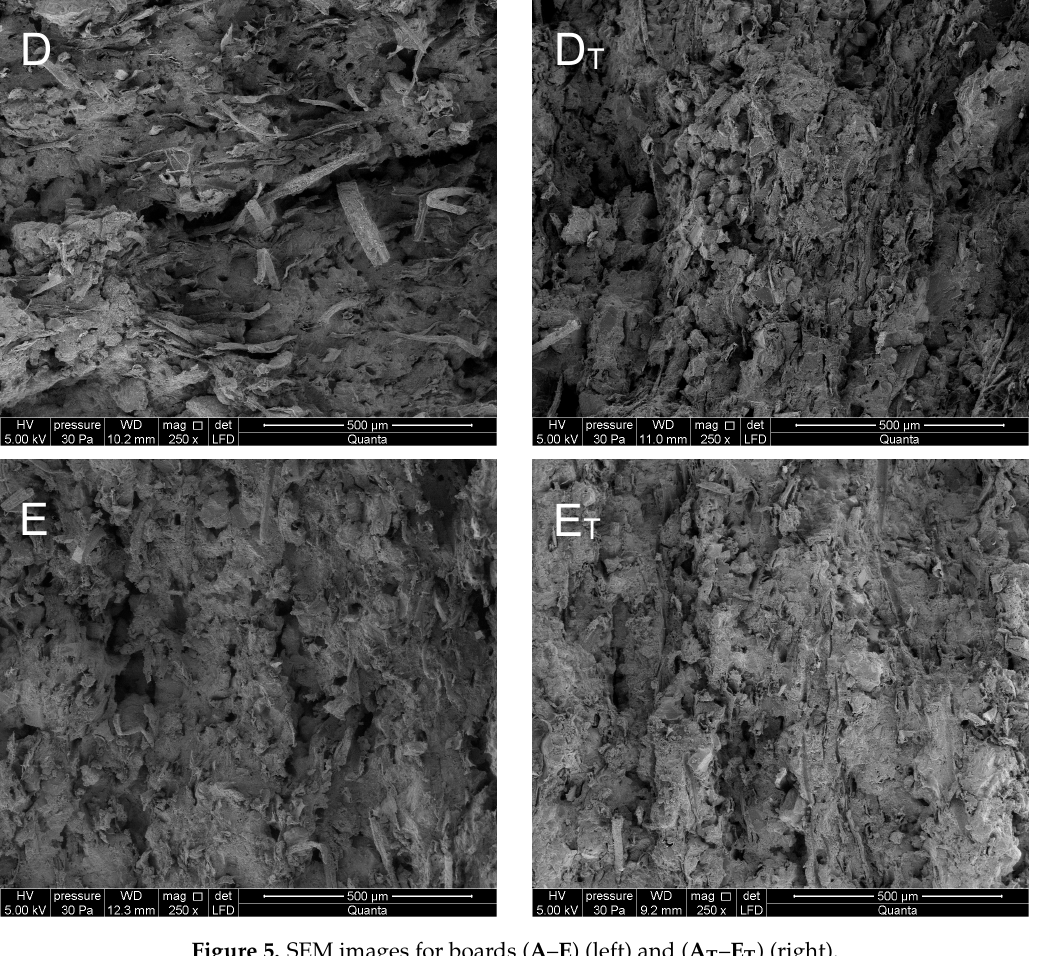
Figure 5. SEM images for boards ( A – E ) (left) and ( A T – E T ) (right).